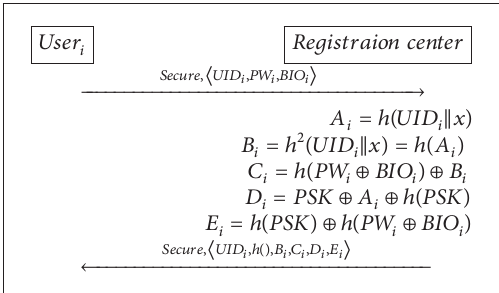
Algorithm 4: Our registration